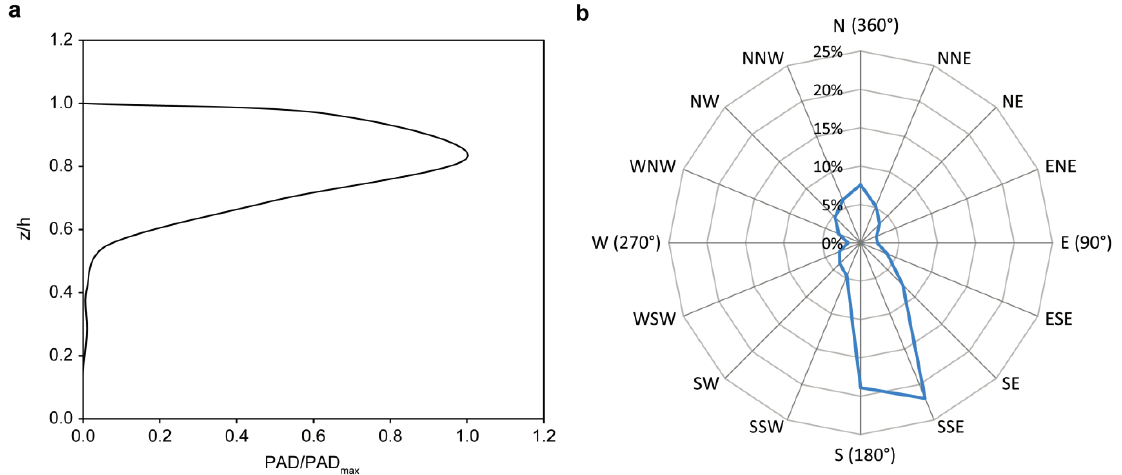
Figure 1. ( a ) Normalized vertical profile of the plant area density (PAD), and ( b ) wind rose at height (cid:1878) (cid:2873) at the measurement